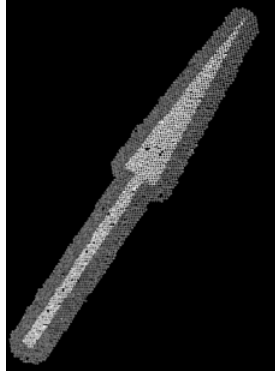
Figure 4. Traffic marking with seven vertices